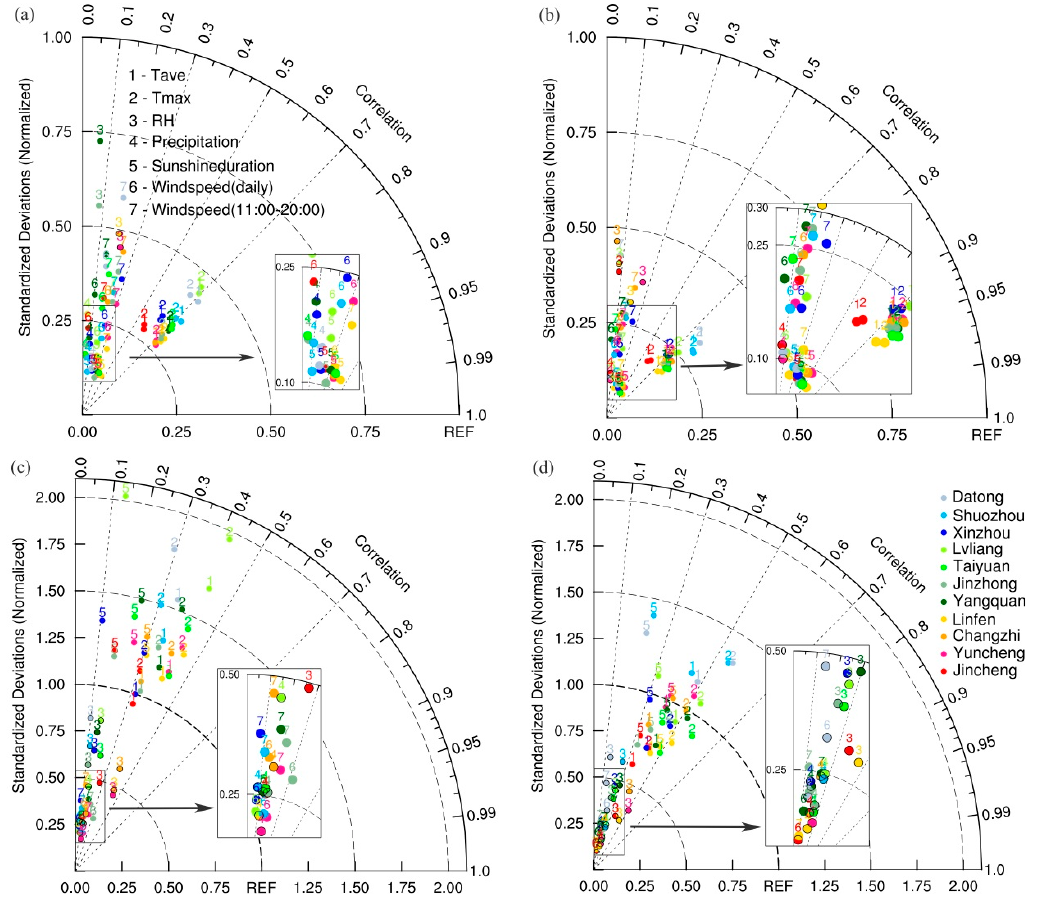
Figure 13. The Taylor diagrams between each meteorological factor and O 3 . ( a ): annual mean value of each meteorological factor and O 3 mass concentration; ( b ): annual mean value of each meteorological factor and MDA8 O 3 ; ( c ): mean value of each meteorological factor and O 3 mass concentration from May to August; ( d ): mean value of each meteorological factor and MDA8 O 3 from May to August. The black circles indicate negative correlation coefficients.